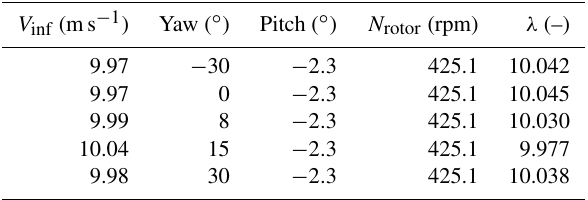
Table 4. Selected load cases from Mexico experiments. V inf is the free stream wind speed, N rotor is the rotational speed of the rotor, λ is the tip speed